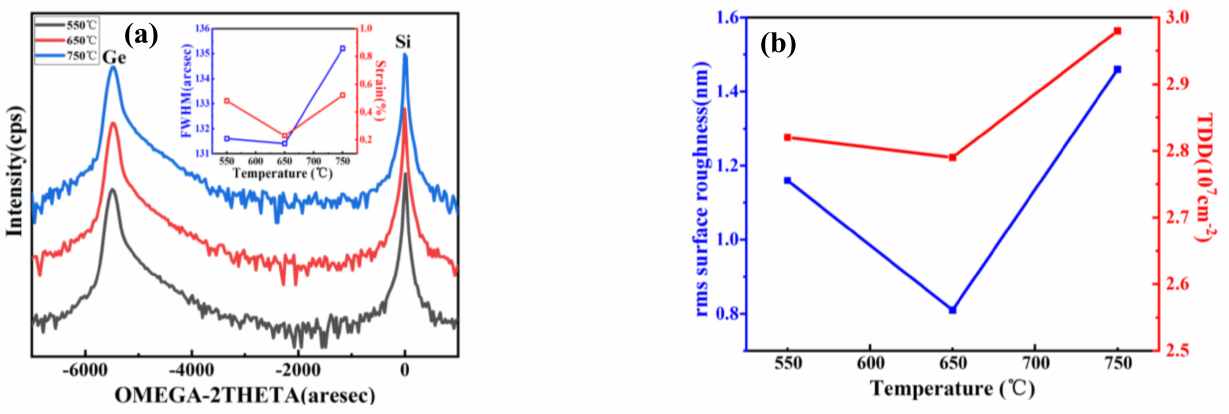
Figure 10. ( a ) HRXRD (004) rocking curves of Ge grow at different temperatures from 550 to 750 ◦ C. The inset shows the calculated strain (right) and FWHM (left) of each Ge curve. ( b ) RMS and calculated TDD